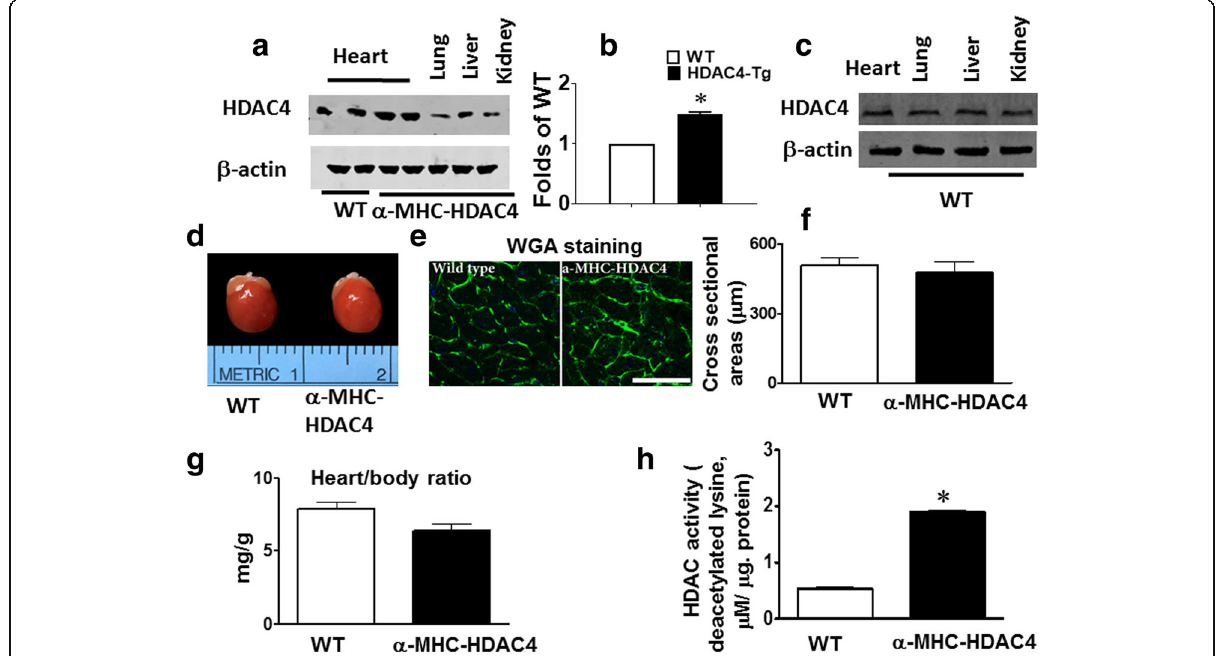
Fig. 1 Generation and characterization of cardiac myocyte-specific HDAC4 transgenic mice. a HDAC4 over-expression in α -MHC-HDAC4 mice and wild type mice; b Densitometric analysis of HDAC4 proteins from the heart; c HDAC4 proteins in heart and other organs in wild type mice (scale bar= 50 μ m); d Isolated hearts from α -MHC-HDAC4 mice and wild type mice; e WGA staining of cardiomyocytes of α -MHC-HDAC4 mice and wild type mice; f Cardiomyocyte sizes in α -MHC-HDAC4 mice and wild type mice; g Heart/body weight ratio from α -MHC-HDAC4 mice and wild type mice; h HDAC activity measured from α -MHC-HDAC4 mice and wild type mice; values are present as Mean Values representing mean±SE ( n =3 – 5/per group)